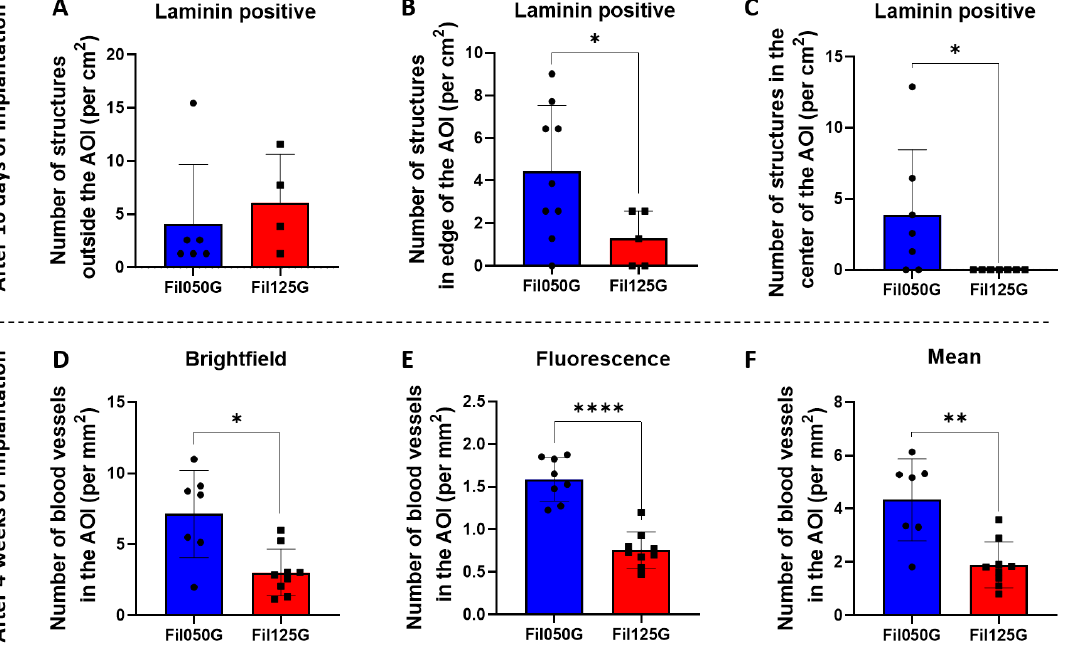
Figure 8. Laminin-positive structure ( A – C ) and blood vessel ( D – F ) quantification after 10 days and 4 weeks and implantation, respectively. ( A ) Number of Laminin-positive structures outside of the area of interest. ( B ) Number of Laminin-positive structures in the edge of the area of interest ( C ) Number of Laminin-positive structures in the center of the area of interest. ( D ) Number of blood vessels counted under brightfield light on histological section. ( E ) Number of blood vessels counted under fluorescent light on histological section. ( F ) Mean of counts under brightfield and fluorescent light on histological section. p -values are indicated as follow; * p < 0.05, ** p < 0.01, and **** p < 0.0001.